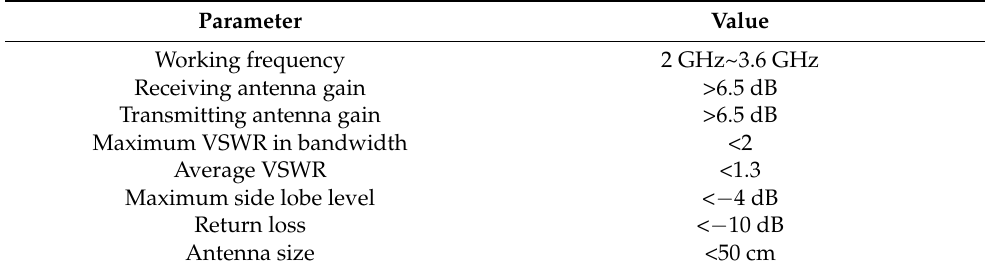
Table 4. Antenna design